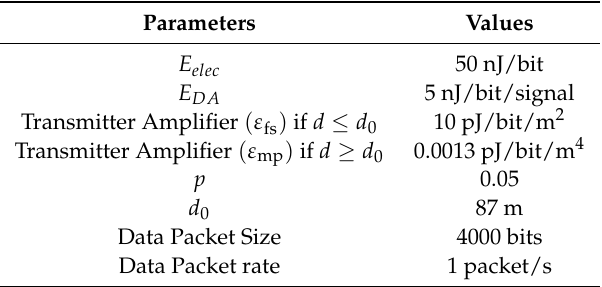
Table 1. Simulation